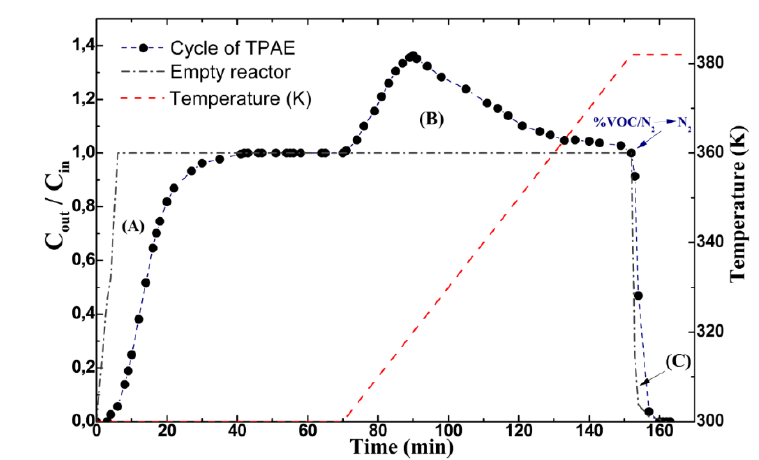
Figure 4. Evolution of o -xylene concentration at the reactor outlet obtained with bentonite clay during TPAE experiments using a 0.395% o -xylene/N 2